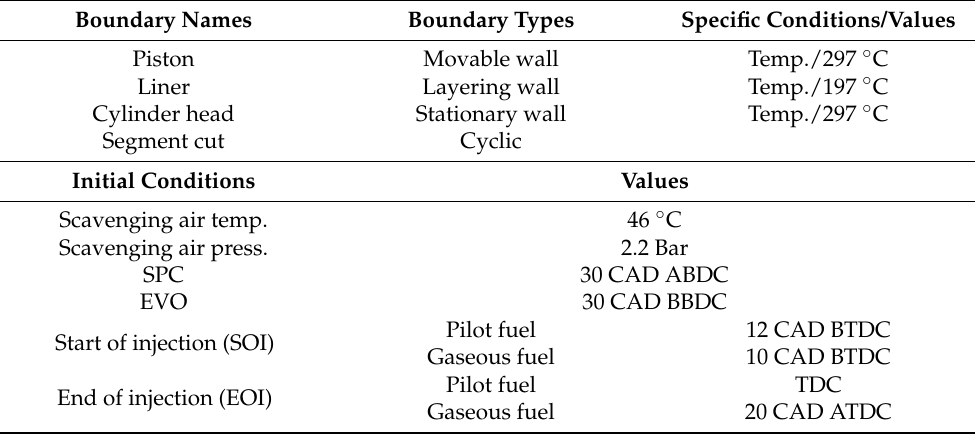
Table 6. Boundary and initial conditions for the CFD numerical simulations.